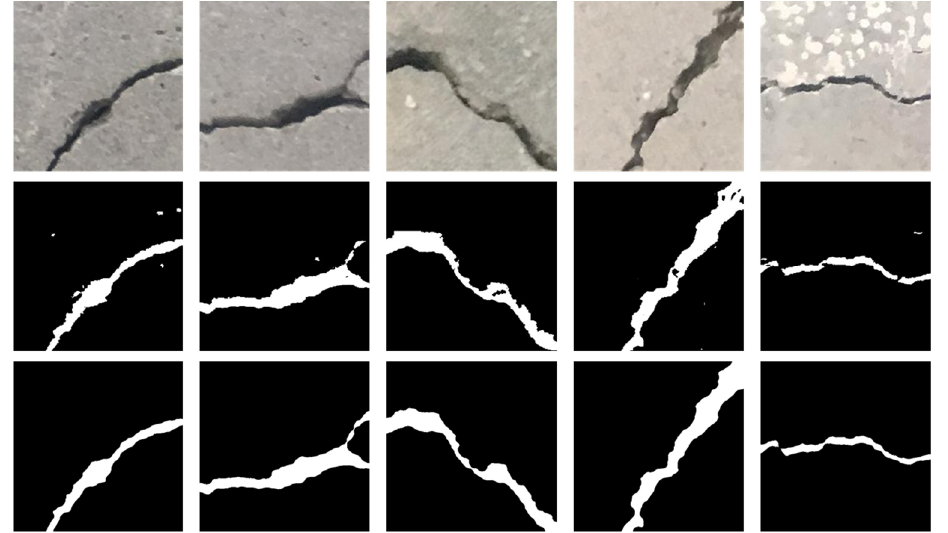
Figure 13. Five randomly selected examples: original image ( upper ), and their first-round GT ( middle ), and second-round GT ( bottom ).